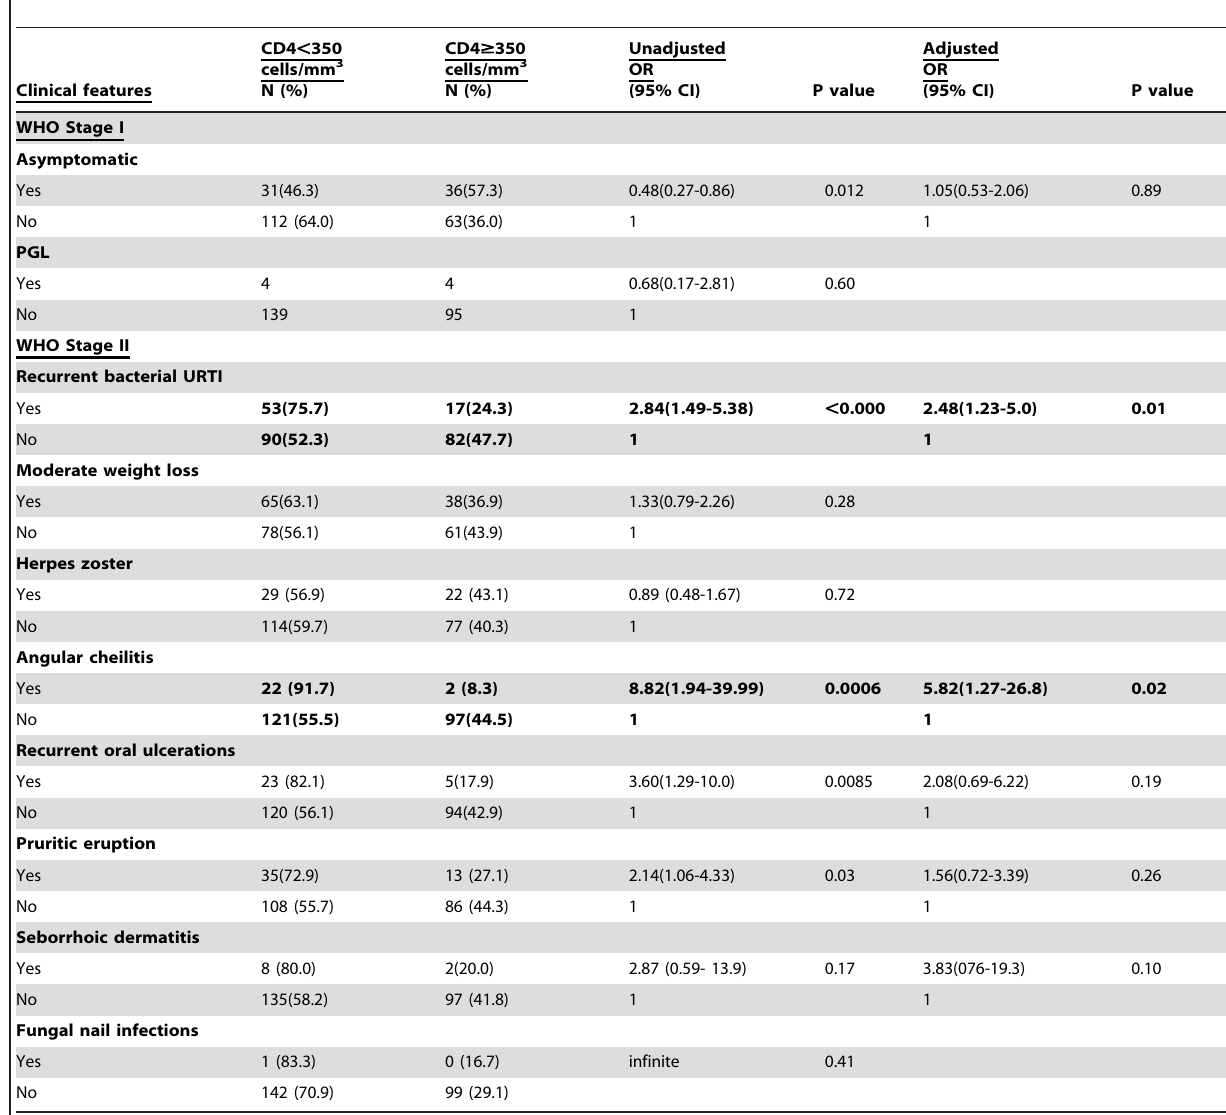
Table 4. Association between CD4 , 350cells/mm 3 and the Clinical Features of the WHO HIV/AIDS clinical stages I & II among the 242 participants in Stages 1 and